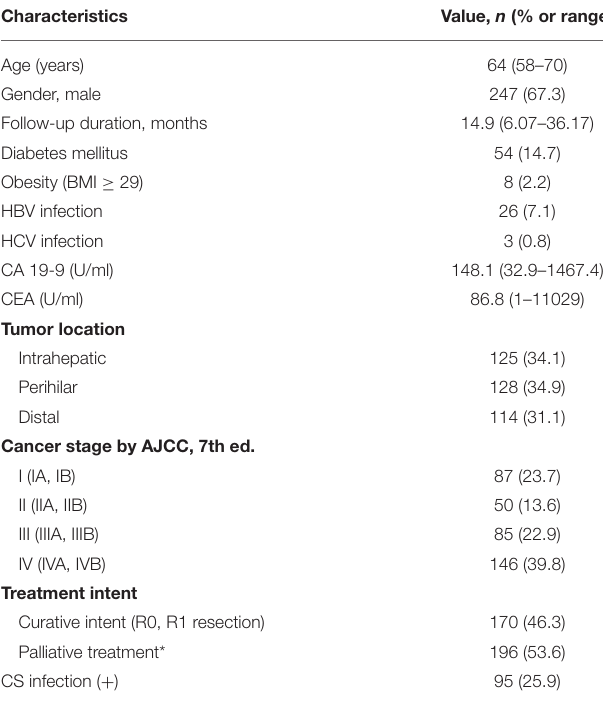
TABLE 2 | Comparison of clinical characteristics of cholangiocarcinoma patients according to Clonorchis sinensis infection. Characteristics